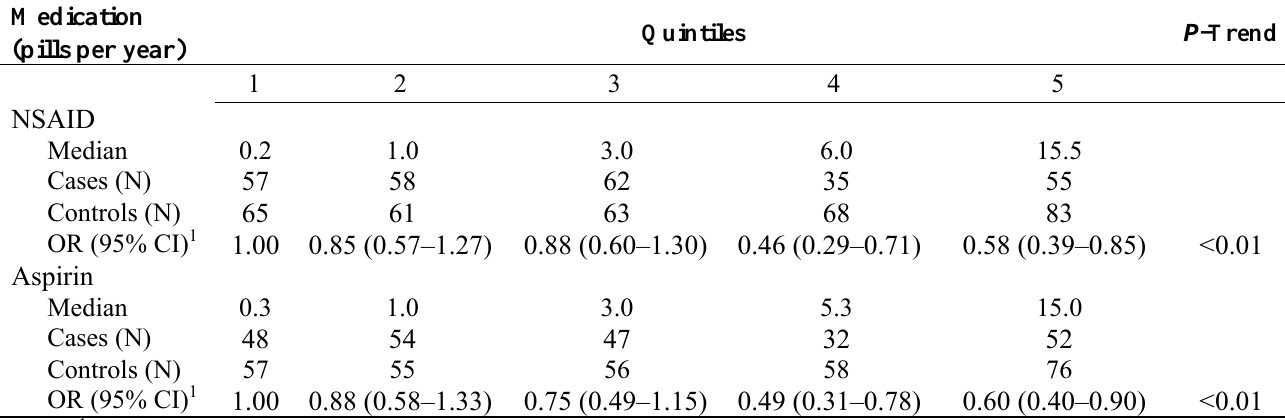
Table 4. Odds ratios and 95% Confidence Intervals for aggressive prostate cancer by pills per year of NSAID use